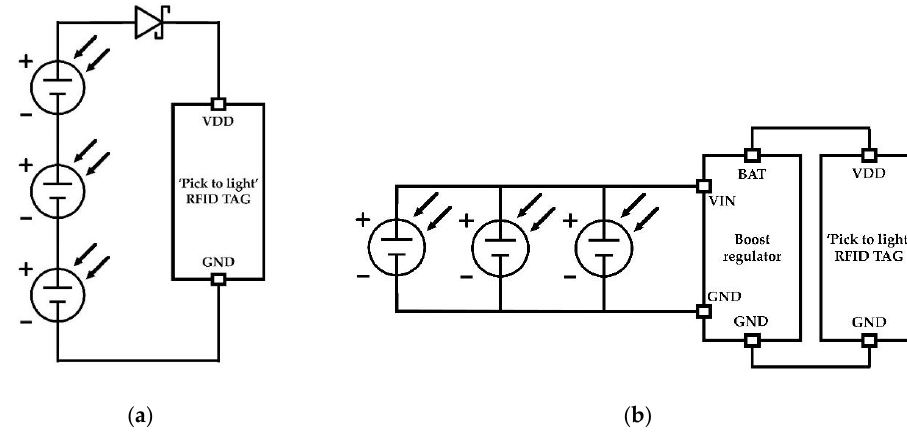
Figure 9. Proposed arrangements to supply the “pick to light” tag with the IXYS KXOB25-05X3F photovoltaic cell: ( a ) three photovoltaic (PV) cells in series with a Schottky diode; ( b ) three photovoltaic cells in parallel with a boost